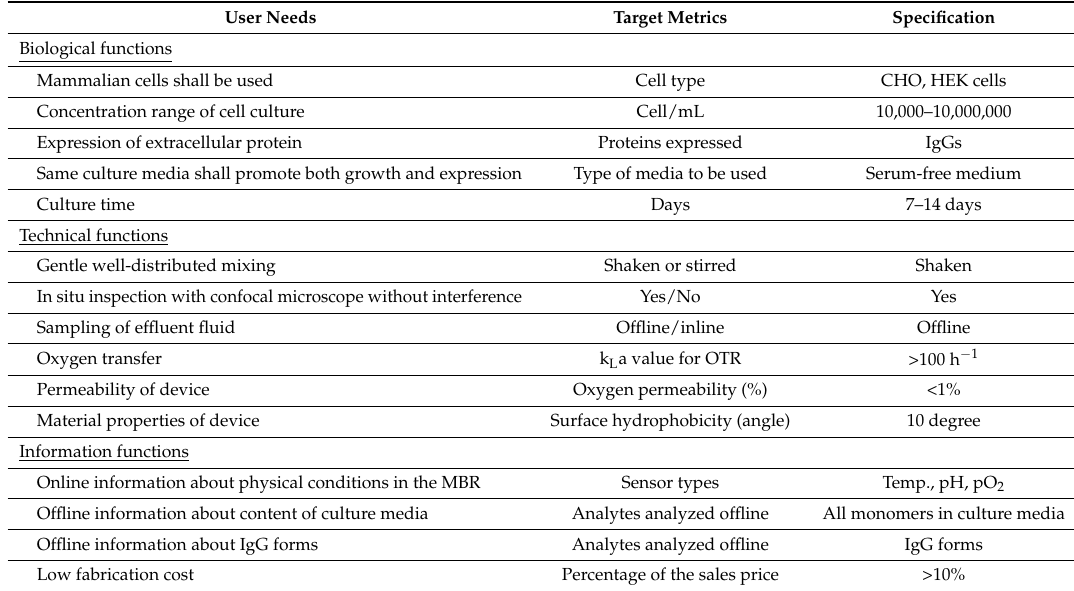
Table 4. User needs of a micro-bioreactor for process development of mammalian cell